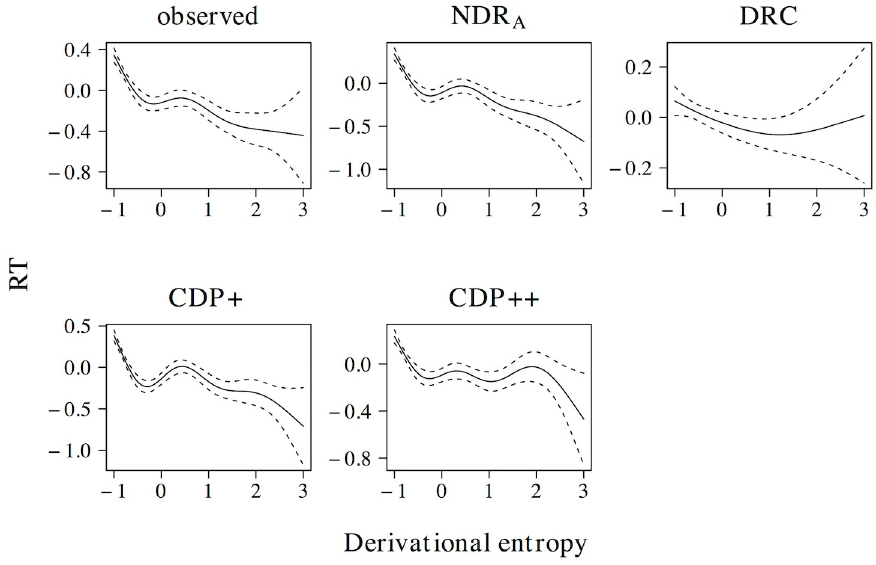
Fig 22. Derivational entropy. The effect of derivational entropy in word